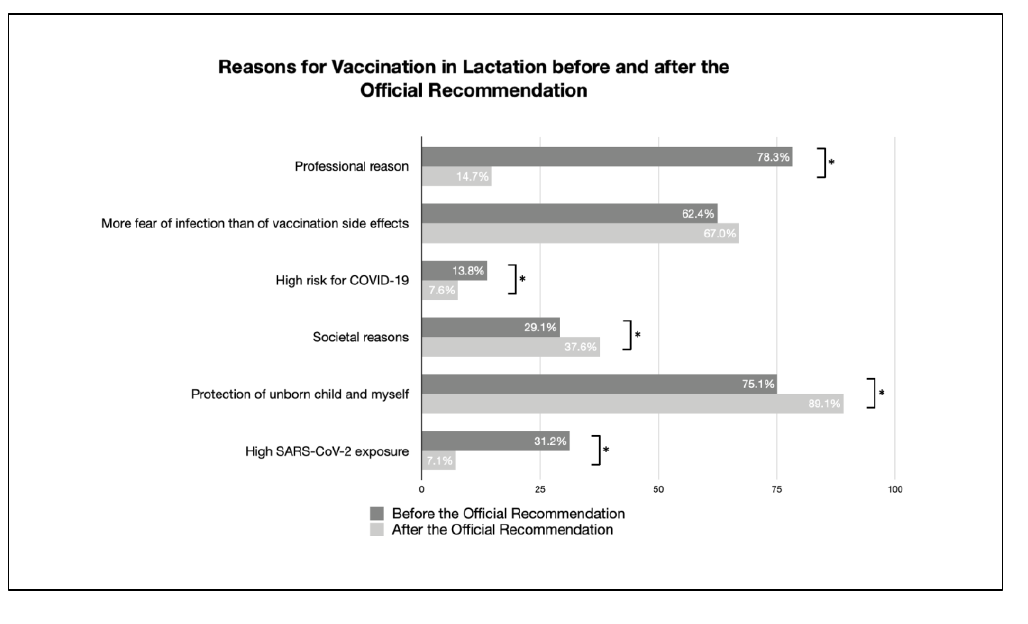
Figure 5. Reasons for vaccination in lactation before and after the official recommendation (percentage of reasons given by participants for being vaccinated; multiple answers possible; * indicates a significant difference).